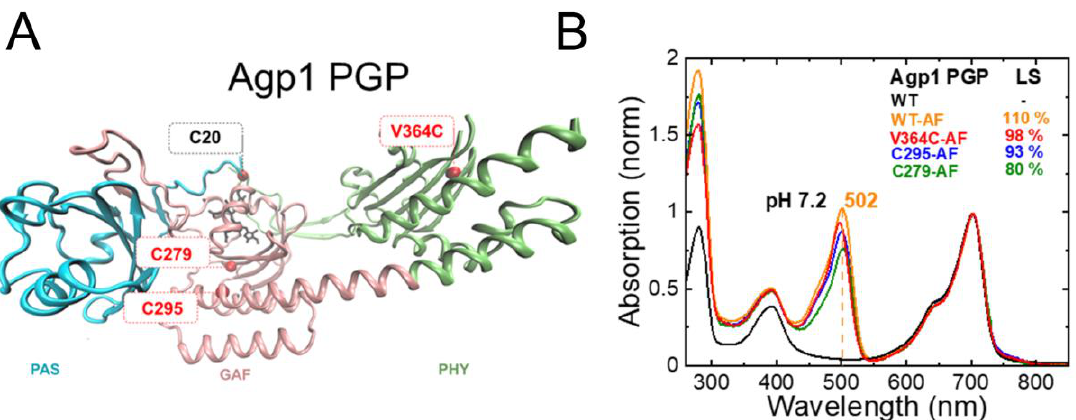
Figure 3. Agp1 PGP structure, single accessible cysteine mutants, and fluorescein-labeling. ( A ) Structural model of Agp1 PGP (PDB 5I5L) with accessible single cysteines for fluorescence labeling in the indicated in red (C279 and C295 as cysteines in the native sequence, and V364C as a cysteine introduced in the PHY domain), the PCB chromophore attached to Cys20 in black. To introduce single accessible cysteine, the following mutants were constructed: C297S/C295, C295S/C279, and C279S/C295S/V364C. The PAS, GAF, and PHY domains are colored in blue, pink, and green, respec- tively. The figure was generated with VMD. ( B ) Pr absorption spectrum of Agp1 PGP and IAF- labeled variants at pH 7.2, normalized to the chromophore peak at 702 nm; WT in black, WT-AF in orange, V364C-AF in red, C295-AF in blue, and C297-AF in green. Labeling was performed as de- scribed in Material and Methods and the labeling stoichiometry (LS) was calculated according to Eq. 1, which yielded LS of 110%, 98%, 93%, and 80% for WT-AF, V364C-AF, C295-AF, and C297-AF, respectively. In WT, the two cysteines C295 and C279 are partly accessible as evidenced by the LS below 200%. The maximum absorption wavelength of the fluorescein peak in WT is indicated. Con- ditions: 300 mM NaCl, 50 mM Tris, pH 7.2 at 20 °C.